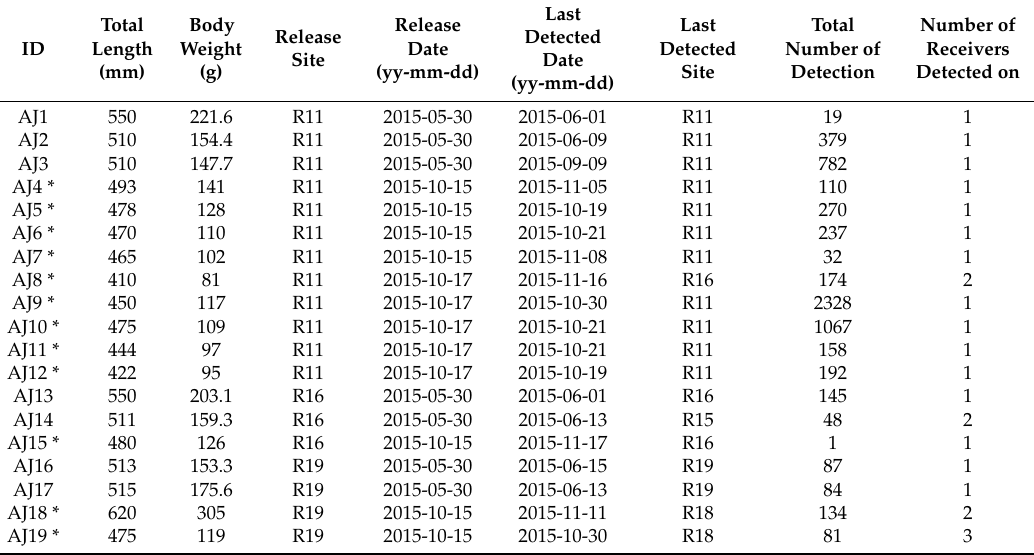
Table 1. Body size, release, and detection information of tagged A. japonica (*, depth